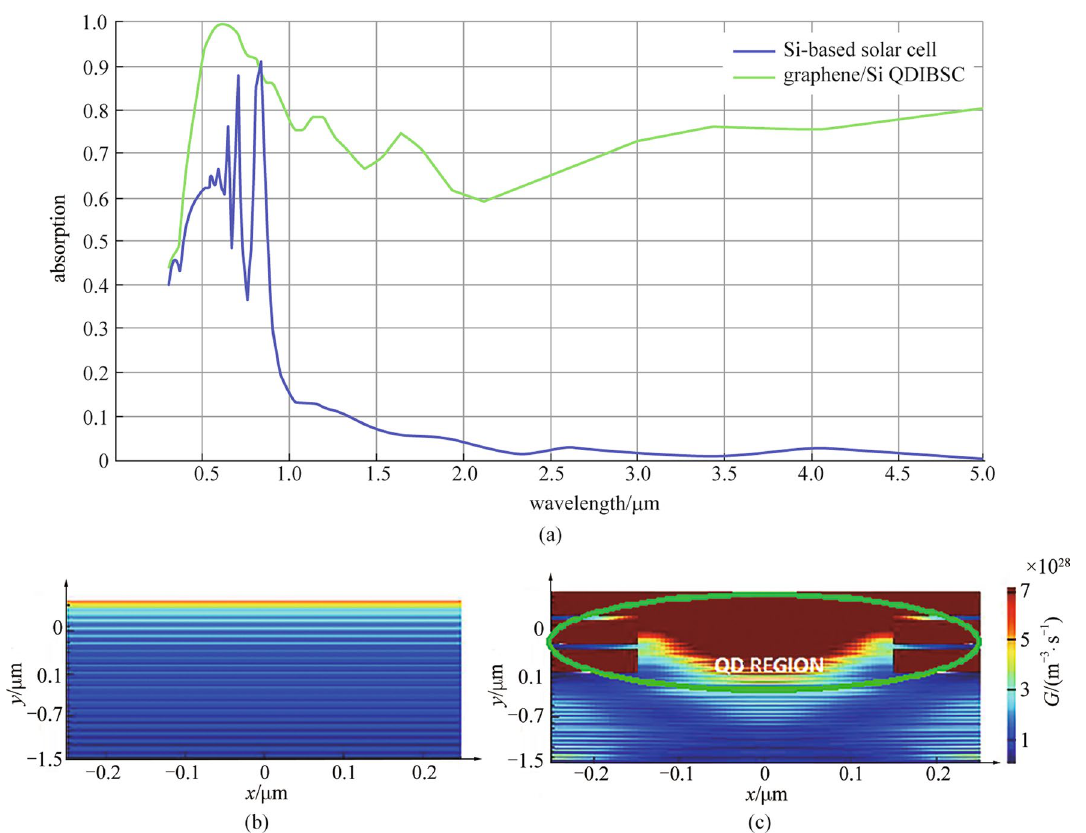
Fig. 6 a Absorption of the Si-based solar cell with active layer thickness of 3 µm and Graphene/Si QDIBSC; b generation rate for Si-based solar cell; c generation rate for Graphene/Si QDIBSC